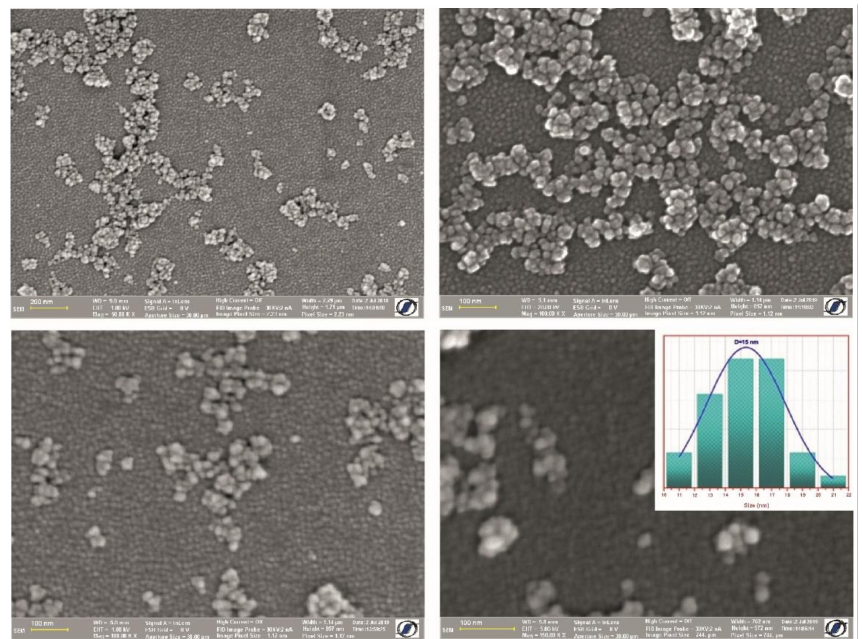
Figure 2. SEM images at different magnification and corresponding size distribution (inset) of the histogram of diameters as-prepared CF@CMC magnetic nanobeads.